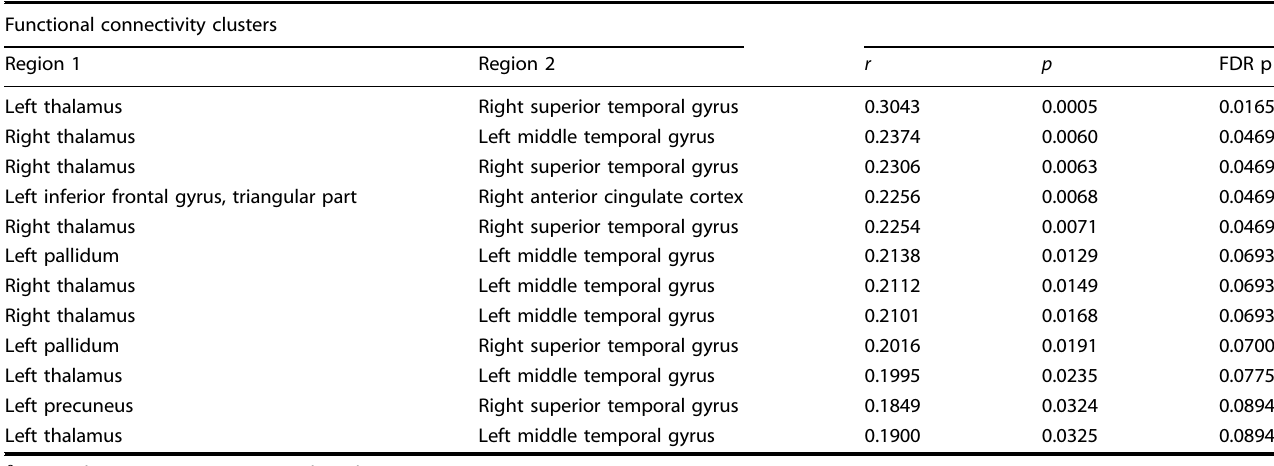
Table 1. Correlations coef fi cient between the functional connectivity links and PANSS negative